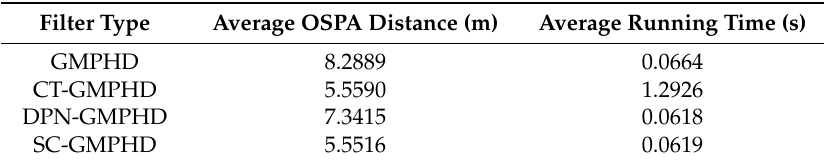
Table 4. Average OSPA distance and RMSE comparison of the four filters for a target on a curved road.